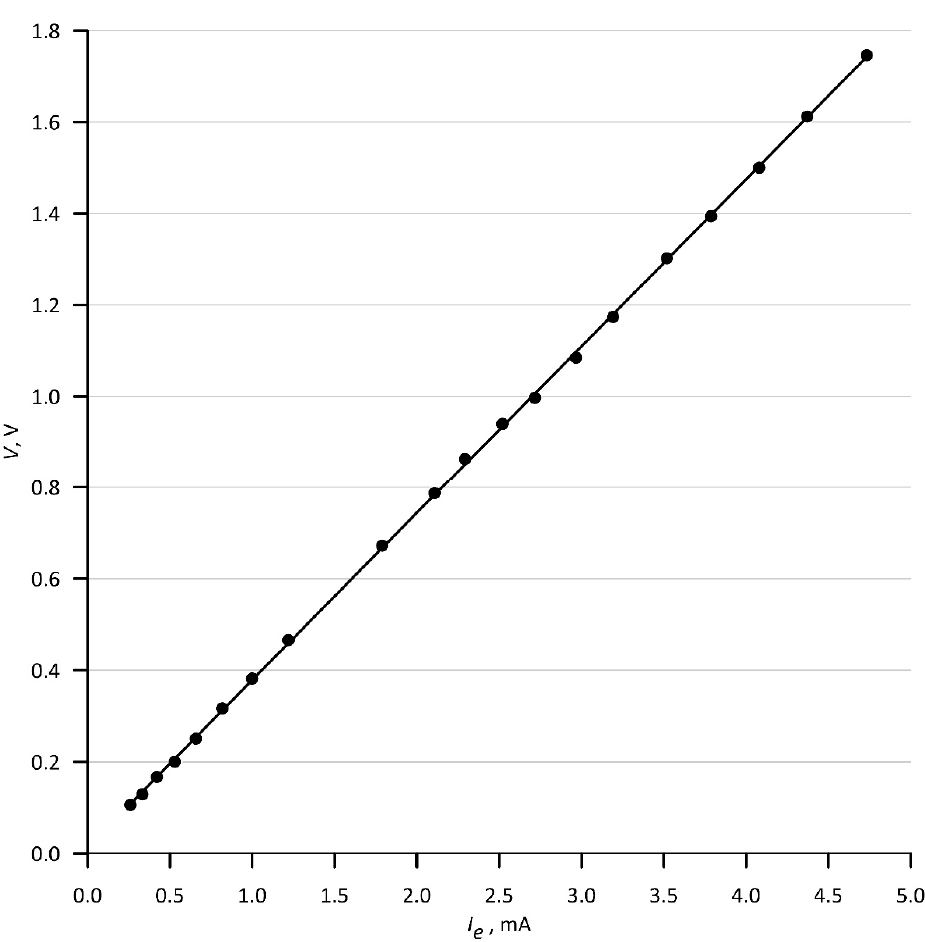
Figure 10. Static characteristic of the emission current to voltage converter. The Type B relative standard uncertainty values of voltage and current are less than 0.013% and 0.029%, respectively.